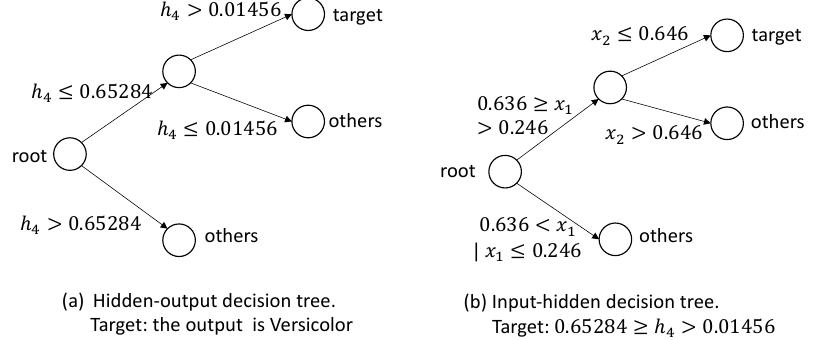
Figure 15. The decision trees for the target Versicolor.